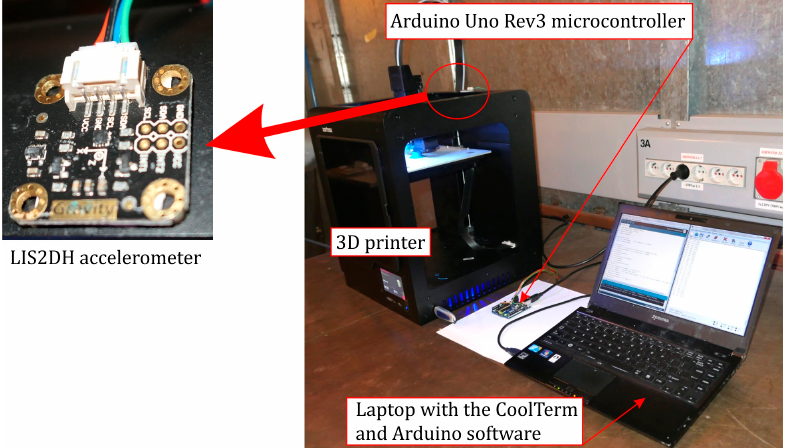
Figure 5. The LIS2DH accelerometer module—real test system.